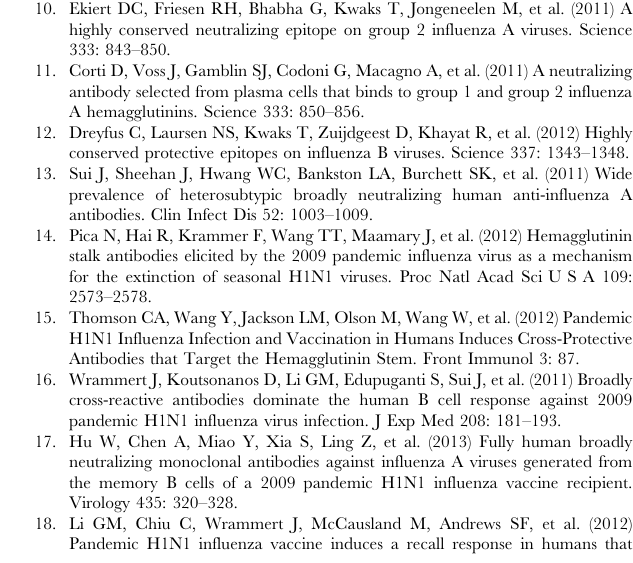
loss and median clinical score data are presented with last observation carried forward for mice that succumb to infection. ( D ) Extrapolated area under the curve (AUC) bodyweight mouse data are depicted per human subject for pre-vaccination, 1 6 , 2 6 , and 3 6 vaccination serum. The extrapolated AUC bodyweight is the area under the curve (AUC) of the change in bodyweight relative to the baseline bodyweight from day 0 up until day 21 after the challenge. The bodyweight of mice that succumb prior to the end of the study is extrapolated using linear exponential decay based on the first and last recorded bodyweights. Each line represents a single subject. Protection against H1N1 is maintained, while protection against H5N1 wanes and is lost one month after